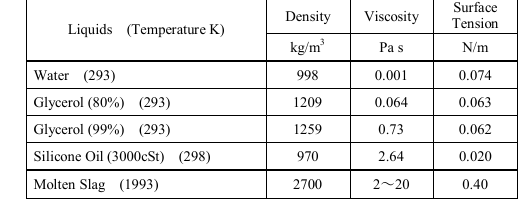
Table 1 Properties of tested liquids and molten slag